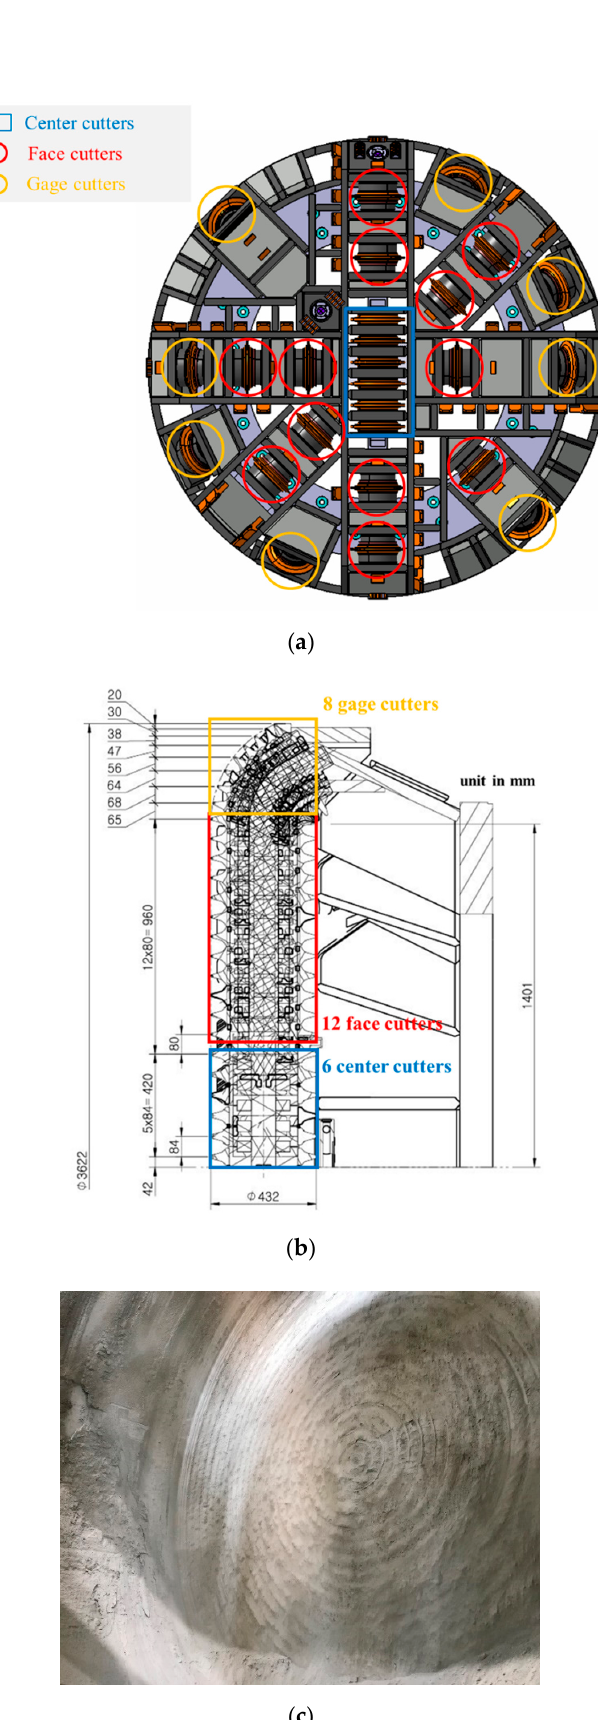
Figure 2. Cutterhead design and tunnel face, ( a ) Schematic view of cutterhead design; ( b ) sectional view depicting cutterhead spacing design; ( c ) Excavation